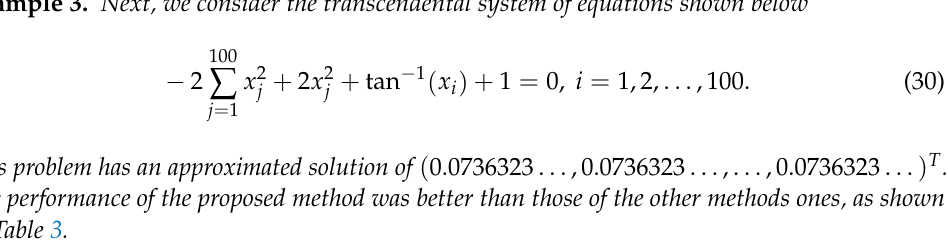
Table 2. The proposed technique performed better than existing scheme AM 5 , whereas scheme